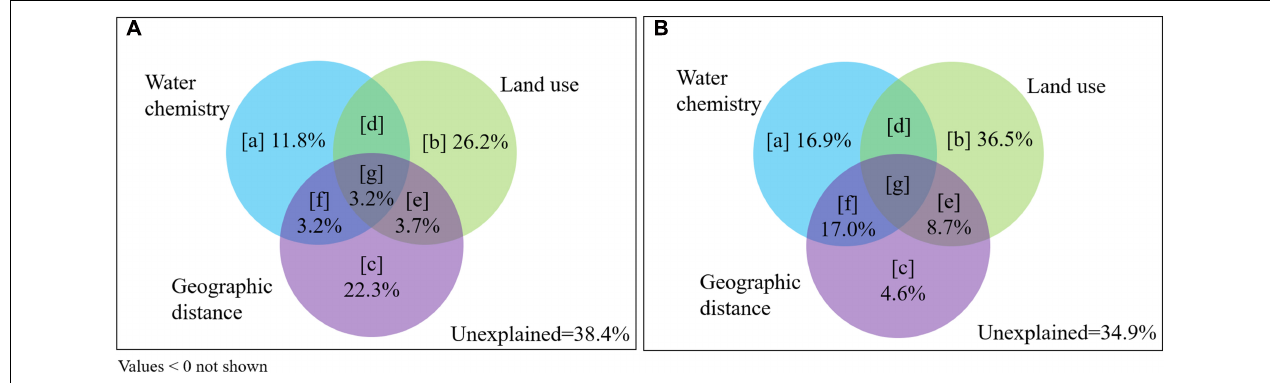
FIGURE 7 | Partitioning of variation in bacterioplankton communities in the Yuan River. The effects on (A) wet season and (B) dry season communities were evaluated based on contributions from water chemistry, land use, and geographic distance parameters, following Supplementary Figure 2 . Panels [a], [b], and [c] stand for the pure contribution of each explanatory matrix; panels [d], [f], and [e] stand for the joint contribution of two explanatory matrices; panel [g] stands for the joint contribution of three explanatory matrices. Unexplained: the variation not explained by the water chemistry, land use patterns or the geographic